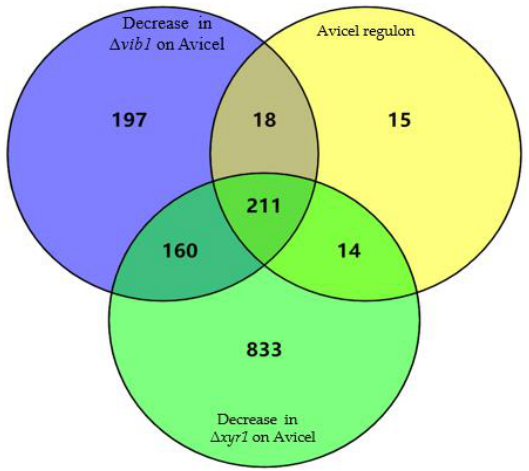
Figure 3. Venn diagram of genes downregulated in Δ vib1 and Δ xyr1 on Avicel compared to the Avicel regulon. Table 2. Fold change of genes encoding cellulase, hemicellulase, sugar transporter, and transcription factor of the Avicel regulon in ∆ vib1 and ∆ xyr1 on